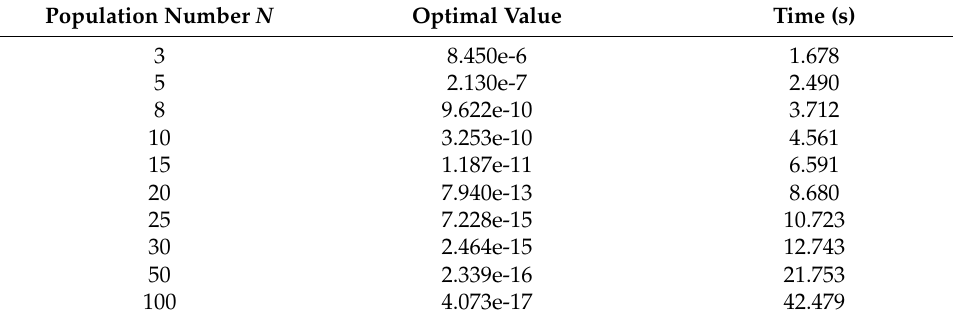
Table 12. The relationship between the population number N and the optimal value of the objective function calculated by the OMO